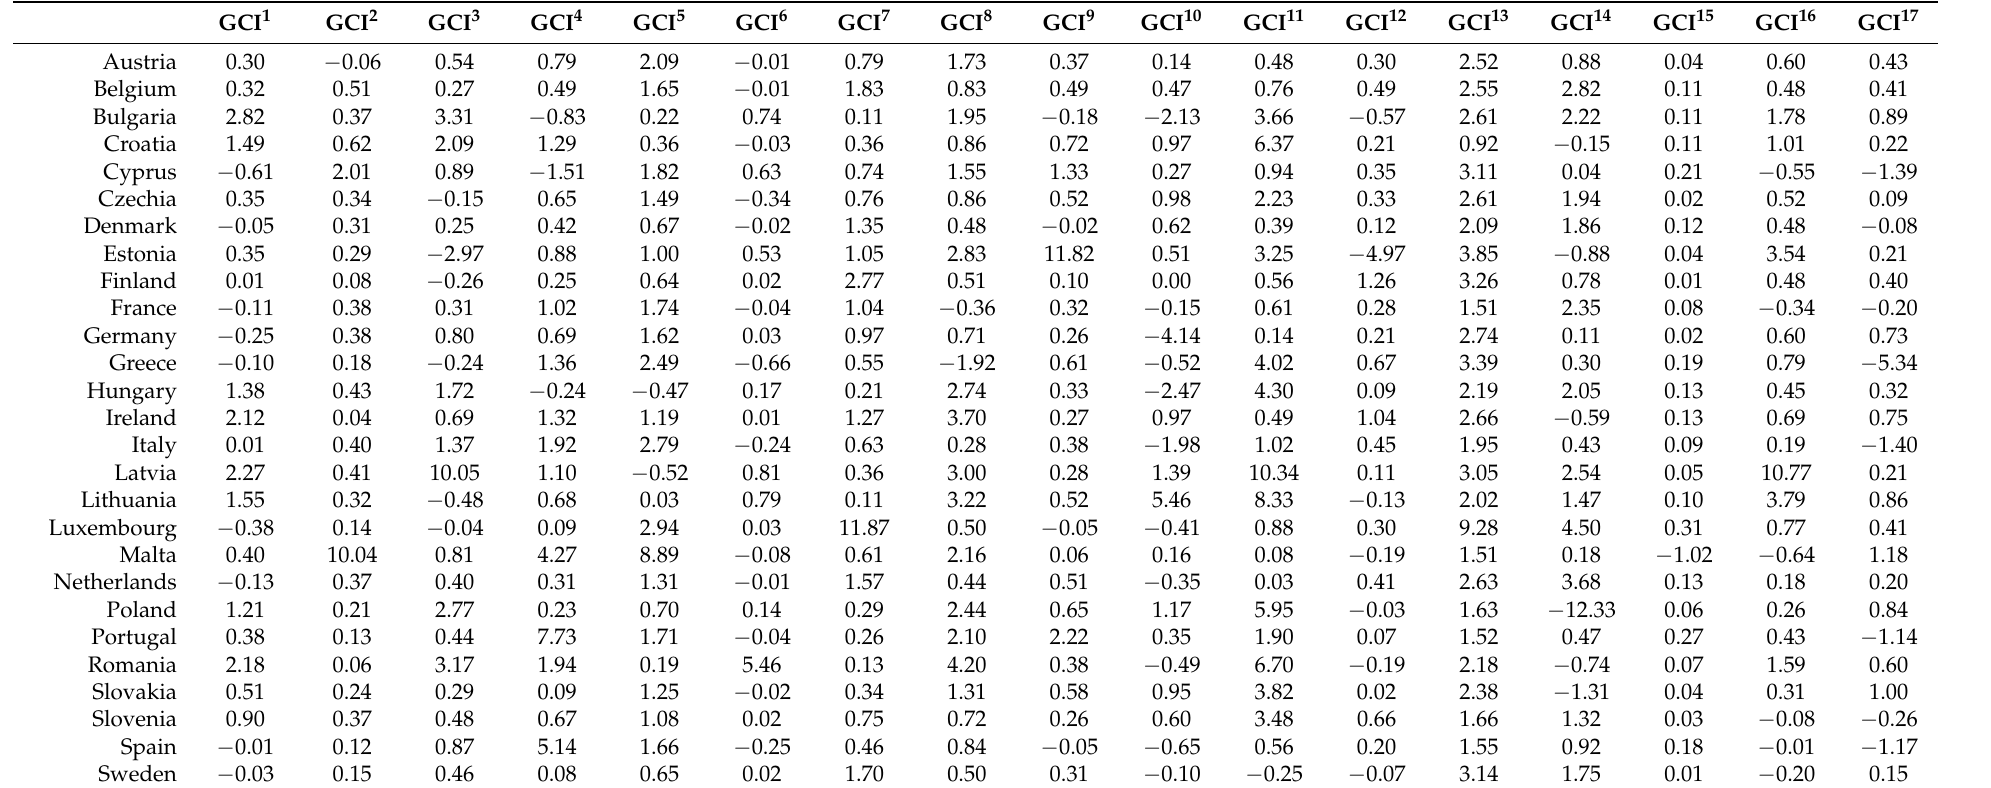
Table 4. SDGs composite indicators’ annual variation rate, 2020–2010, goals 1 to